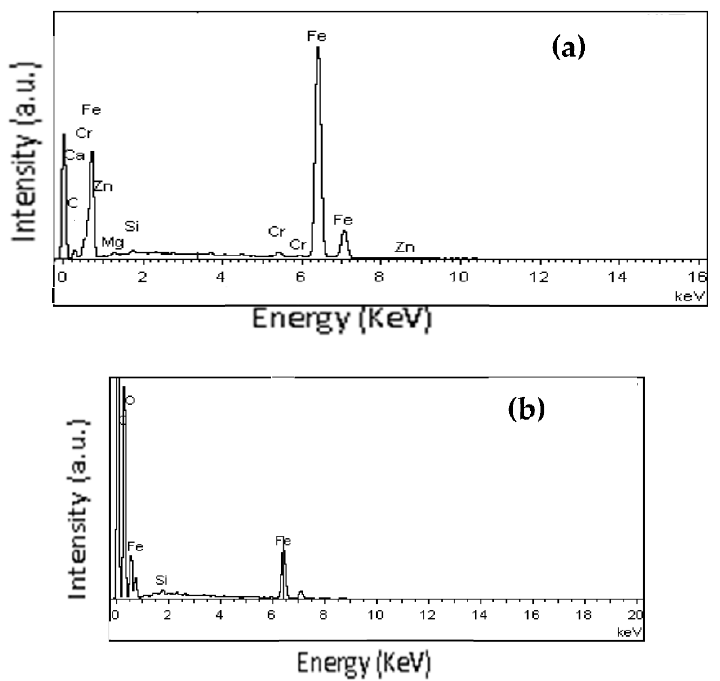
Figure 7. EDS analysis of cylinder liner wear zones with 20 and 80 vol% EBF in FFEO: ( a ) 20 vol% EBF, ( b ) 80 vol% EBF. Table 3. EDS analysis of the cylinder liner wear zones lubricated with 20 vol% and 80 vol% EBF in